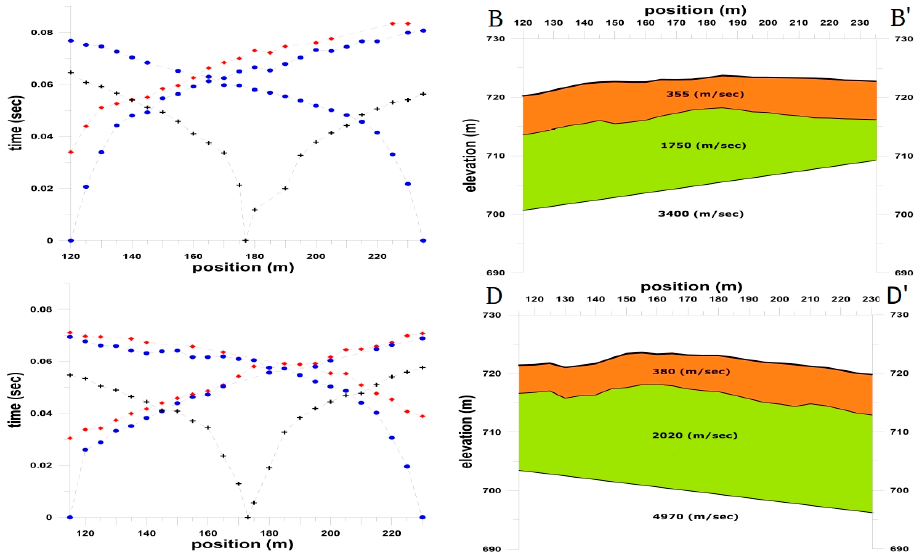
Figure 10. Travel-time vs distance graphs derived from the A - A’ and C - C’ refraction lines data and respective P-wave velocity cross-sections.